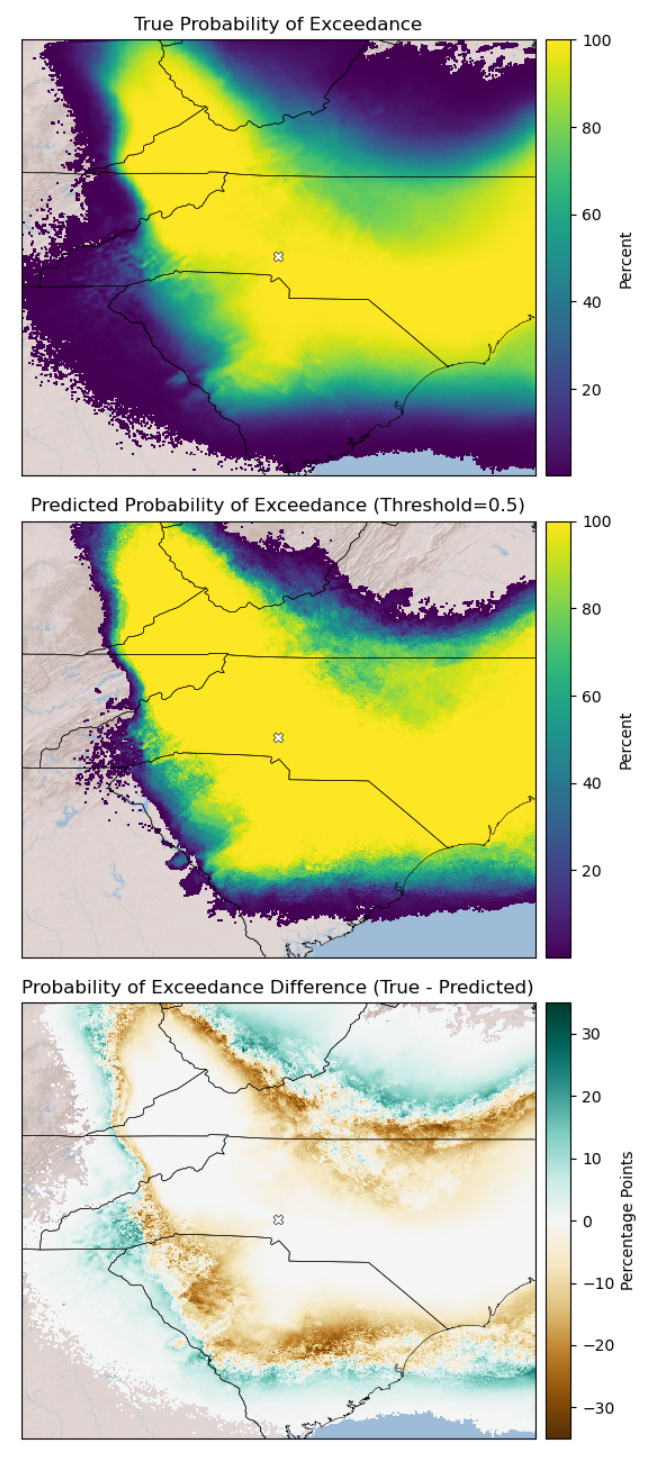
Figure 11. Percentage of members in the true ( top ) and predicted ( center ) ensembles that have deposition that exceeds 0.01 Bq/m 2 at each location. The bottom-most plot shows the difference between the